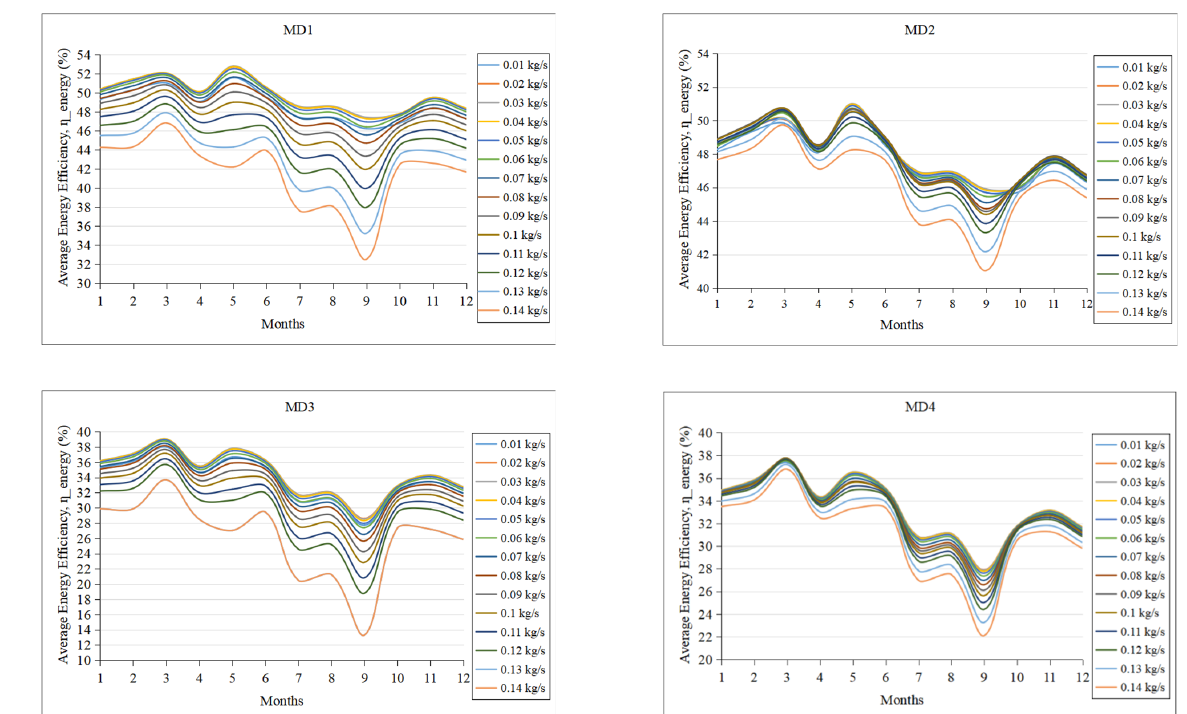
Figure 10. The average energy efficiency of AWHS under flow change.